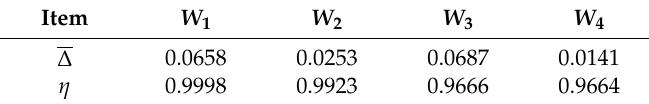
Table 7. Average relative errors and Grey correlation degrees of W 1 , W 2 , W 3 and W 4 .